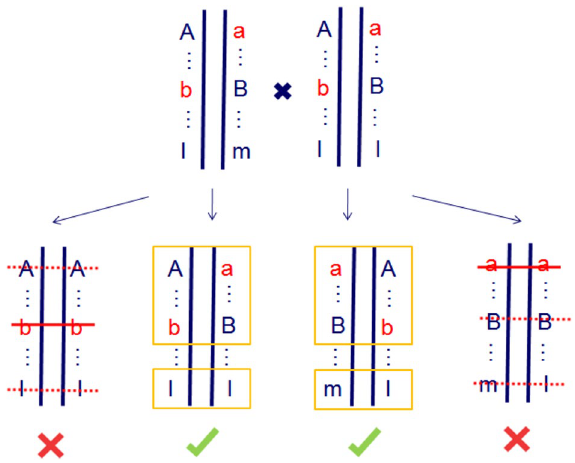
Figure 5. Mode pattern of pseudo-overdominance caused by linkage of detrimental loci and its effect on different types of markers. Three genetic loci are closely linked as haplotypes, and red lowercase indicates partial recessive detrimental alleles. Cross of two heterozygotes have produced four kinds of progenies. Crossed-out lines refer to homozygous detrimental genotypes that will be eliminated, crossed-out imaginary lines indicate neutral genotypes eliminated by hitch-hiking effects. Elimination of homozygous detrimental genotypes leads to a superficial phenomenon of pseudo-overdominance, whereas single-parent heterozygous loci (lm × ll type) do not seem to be affected by